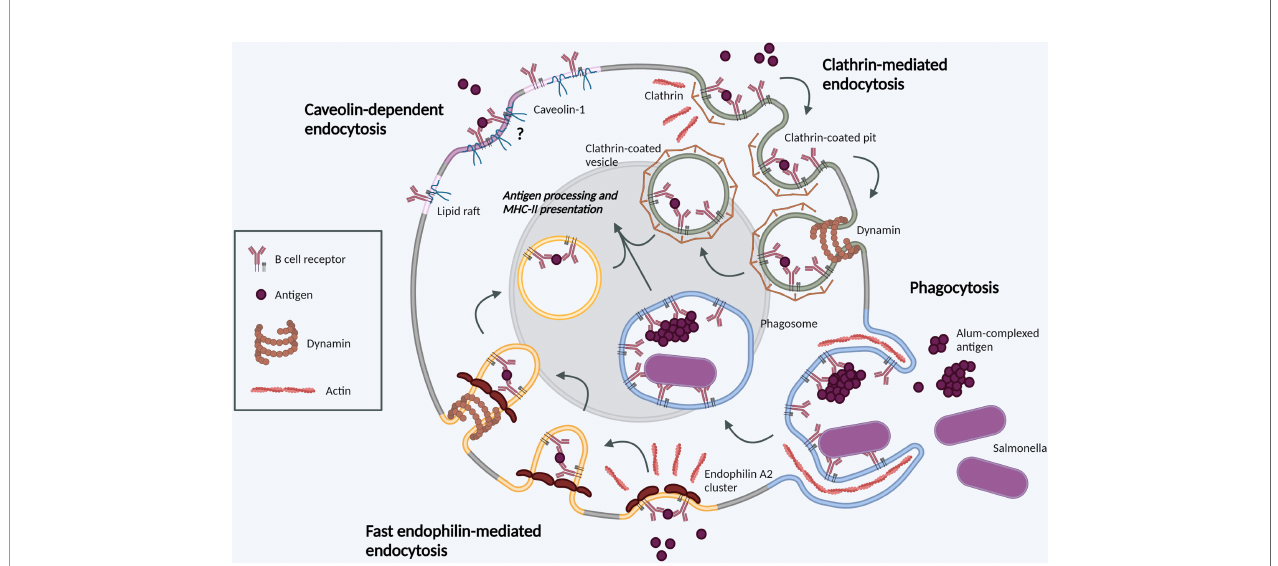
FIGURE 1 | Molecular mechanisms of BCR internalization. Clathrin-mediated endocytosis (green). Following BCR antigen binding, clathrin is recruited to BCR- antigen clusters, binding ITAM residues in the cytoplasmic tails of Ig a and Ig b . Clathrin polymerization induces membrane-curvature and formation of CCPs. CCPs invaginate before scission from the PM mediated by dynamin, forming a CCV. CCVs containing BCR-antigen complexes fuse with late endosomes for antigen processing and subsequent presentation. Phagocytosis (blue). BCR binding to large, particulate antigens can induce local actin rearrangements, driving membrane protrusion to form a large membrane invagination. Once internalized in phagosomes, the membrane vesicle undergoes fusion events in parallel with other endocytic processes. Fast endophilin-mediated endocytosis (yellow). Within endophilin-primed membrane patches, BCR antigen binding results in endophilin-mediated membrane curvature with subsequent dynamin scission to form an intracellular vesicle. This pathway is speci fi c for ligand-triggered, signaling receptors. Caveolin- dependent endocytosis (pink). Caveolin-1 controls the distribution of surface BCR into lipid rafts. Its role in antigen-mediated BCR internalization requires further investigation. Created with